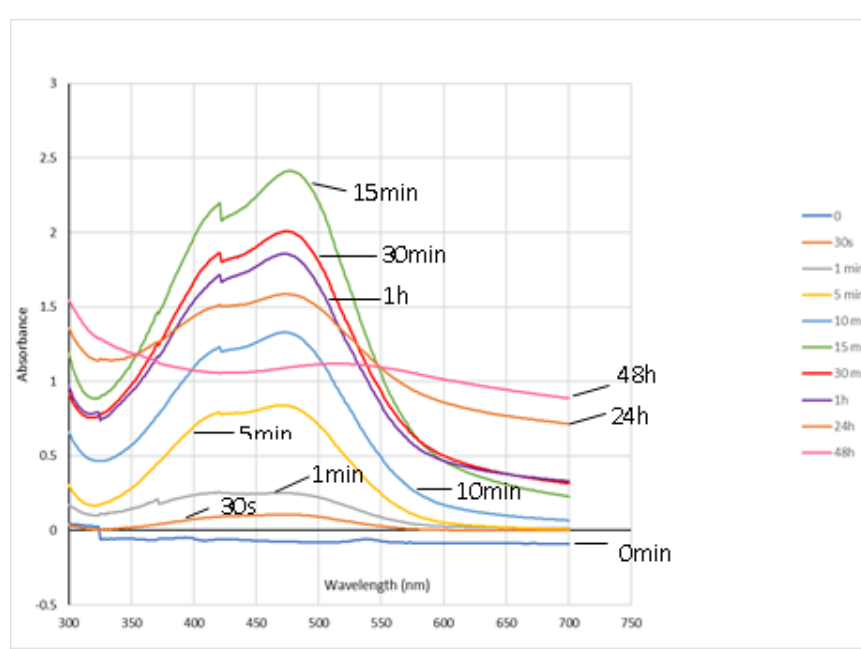
Figure 8. Visible spectrophotometry of guaiacol oxidation products during reaction.